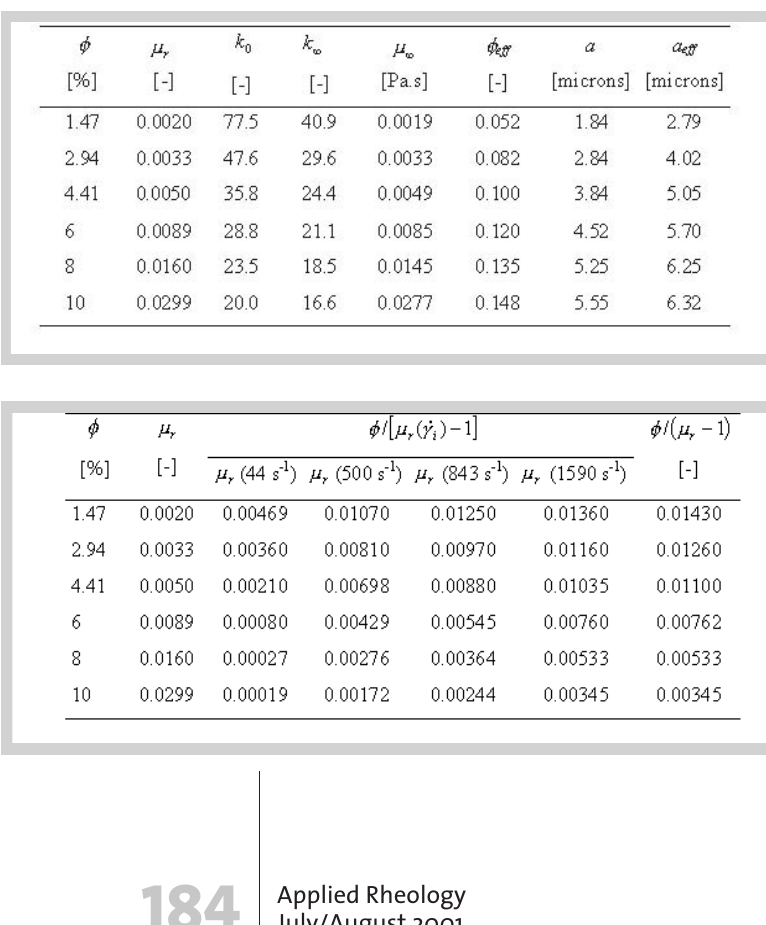
Table 5 (above): Evolution of the effective concentration f eff and the effective mean radius a eff with ben- tonite concentration. Table 6 (below): Parameters used in the Tsutsumi et al. method